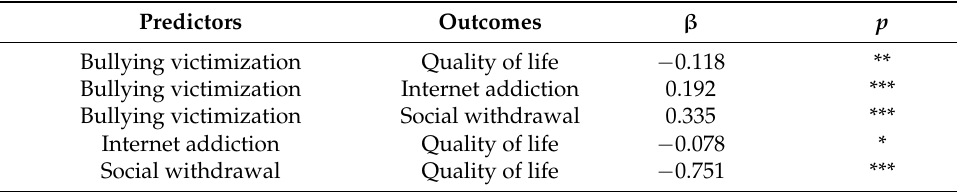
Table 3. Coefficients of path analysis. Predictors Outcomes